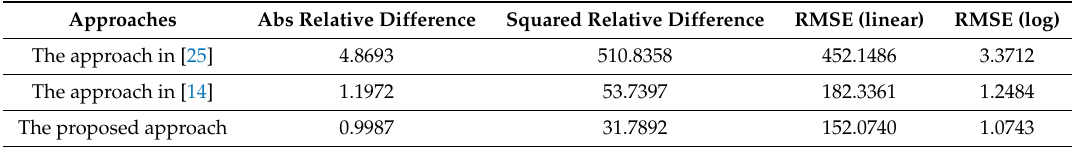
Table 2. Quantitative comparison on the aspects of accuracy and efficiency.